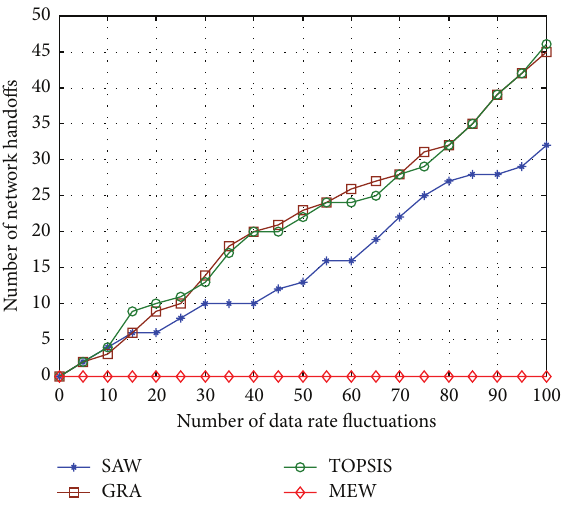
Figure 8: Network handoffs in case of weight 3.